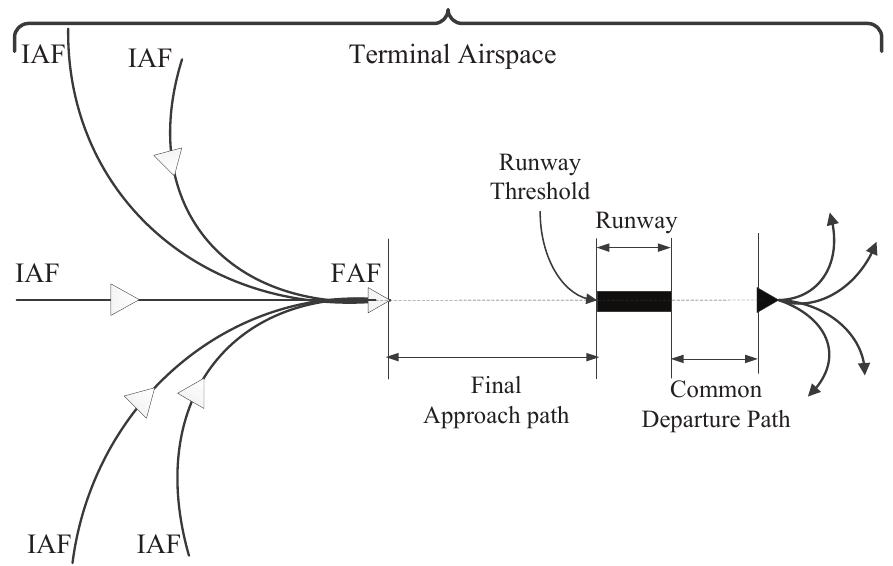
Figure 5. Terminal airspace operation (sequencing at Final Approach Fix (FAF) and threshold). IAF, Initial Approach Fix.